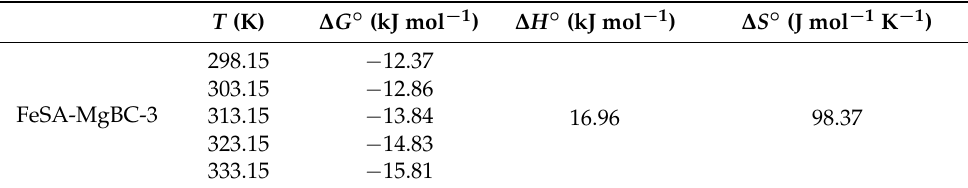
Table 5. Thermodynamic parameters of adsorption in this